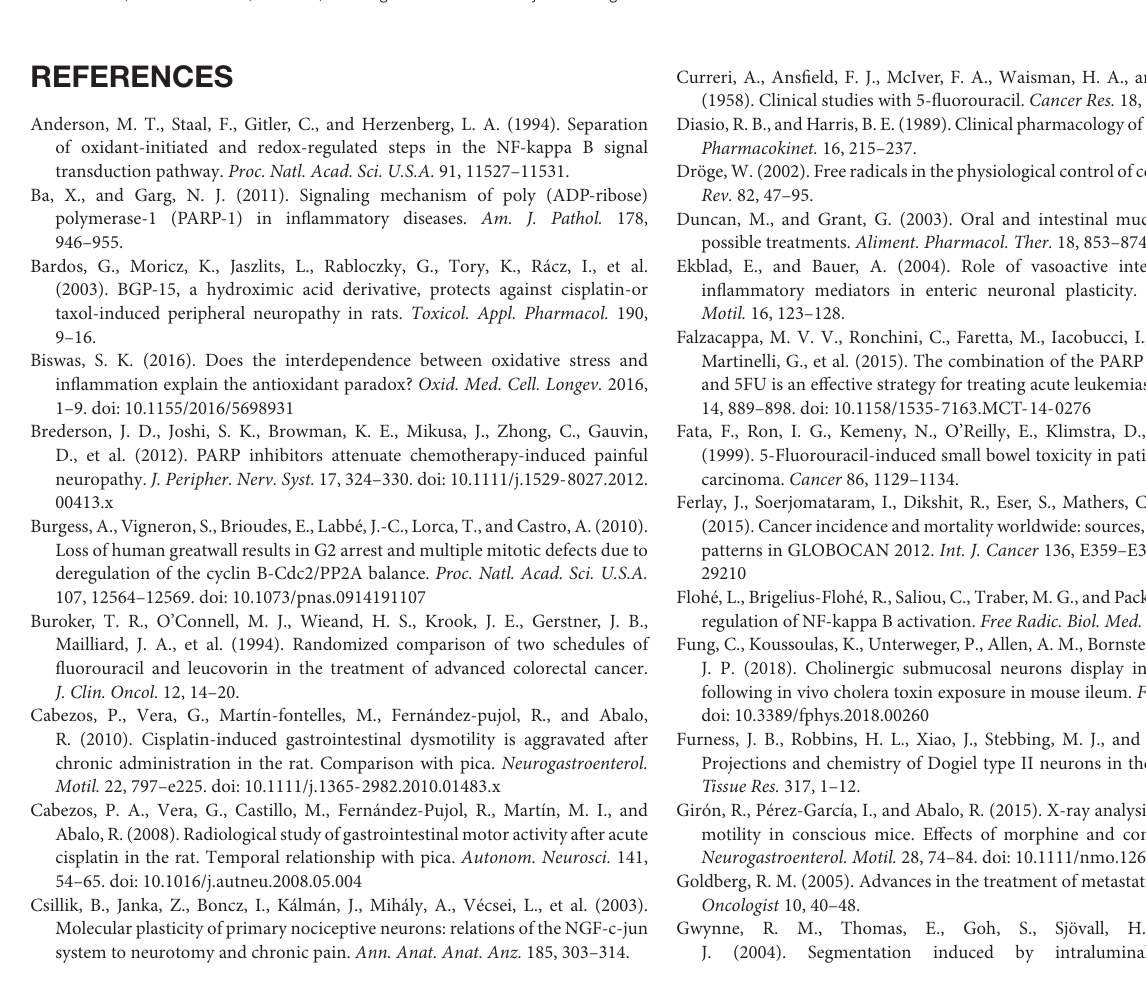
FIGURE S3 | Negative control for immunolabeling with CD45 antibody. Labeling with Alexa-Fluor 488 resulted in no visible stain at baseline fluorescence (A) , at 50% maximum fluorescence labeling with Alexa-Fluor 488 resulted in some autofluorescence, however no discernible CD45+ cells were present (A’) . Representative slide of CD45+ labeling acquired at 50% maximum fluorescence for comparison (B)